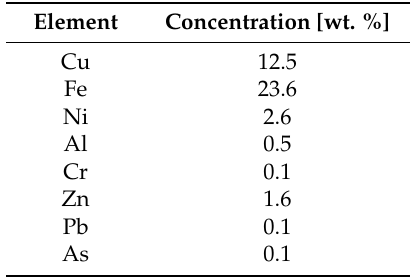
Table 1. Chemical analysis of metals of interest in raw material investigated.